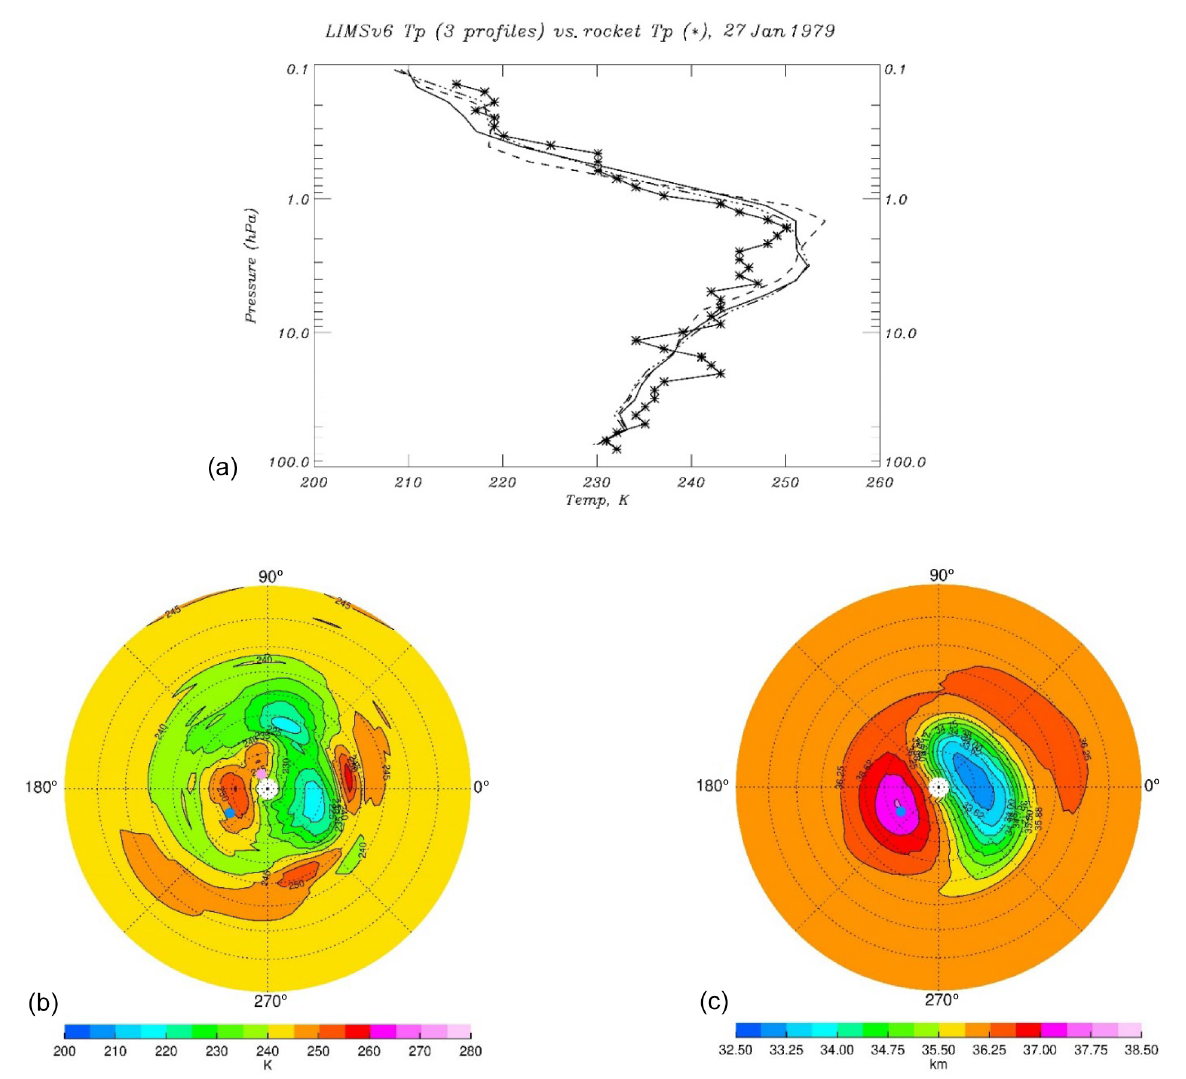
Figure 7. (a) As in Fig. 5 but for 27 January 1979. (b) NH V6 temperature; CI is 5K. Poker Flat is blue, and satellite position is pink. (c) V6 GPH; CI is 0.375gpkm (geopotential